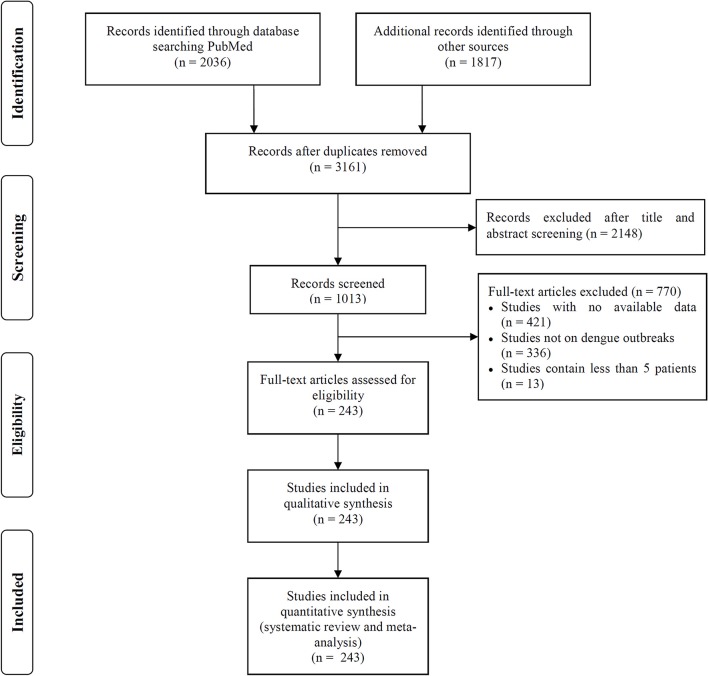
Flowchart of literature selection process in this study.